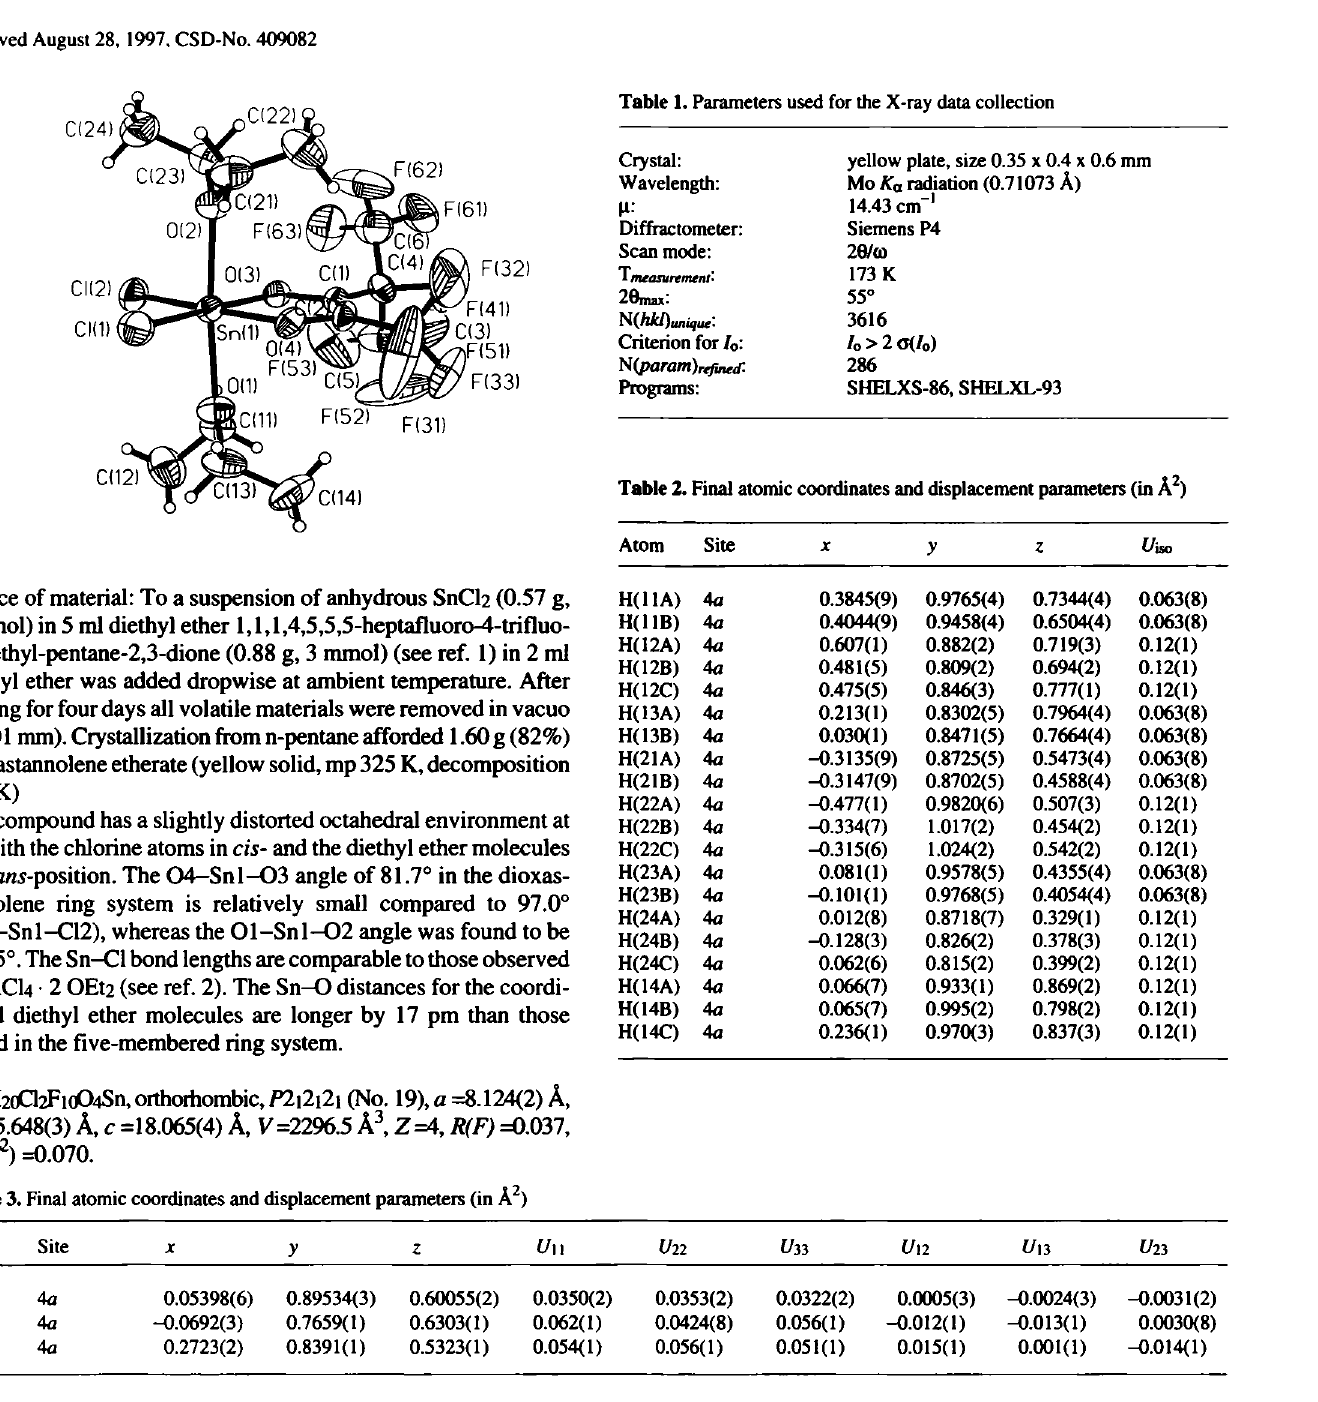
Table 3. Final atomic coordinates and displacement parameters (in Â^)